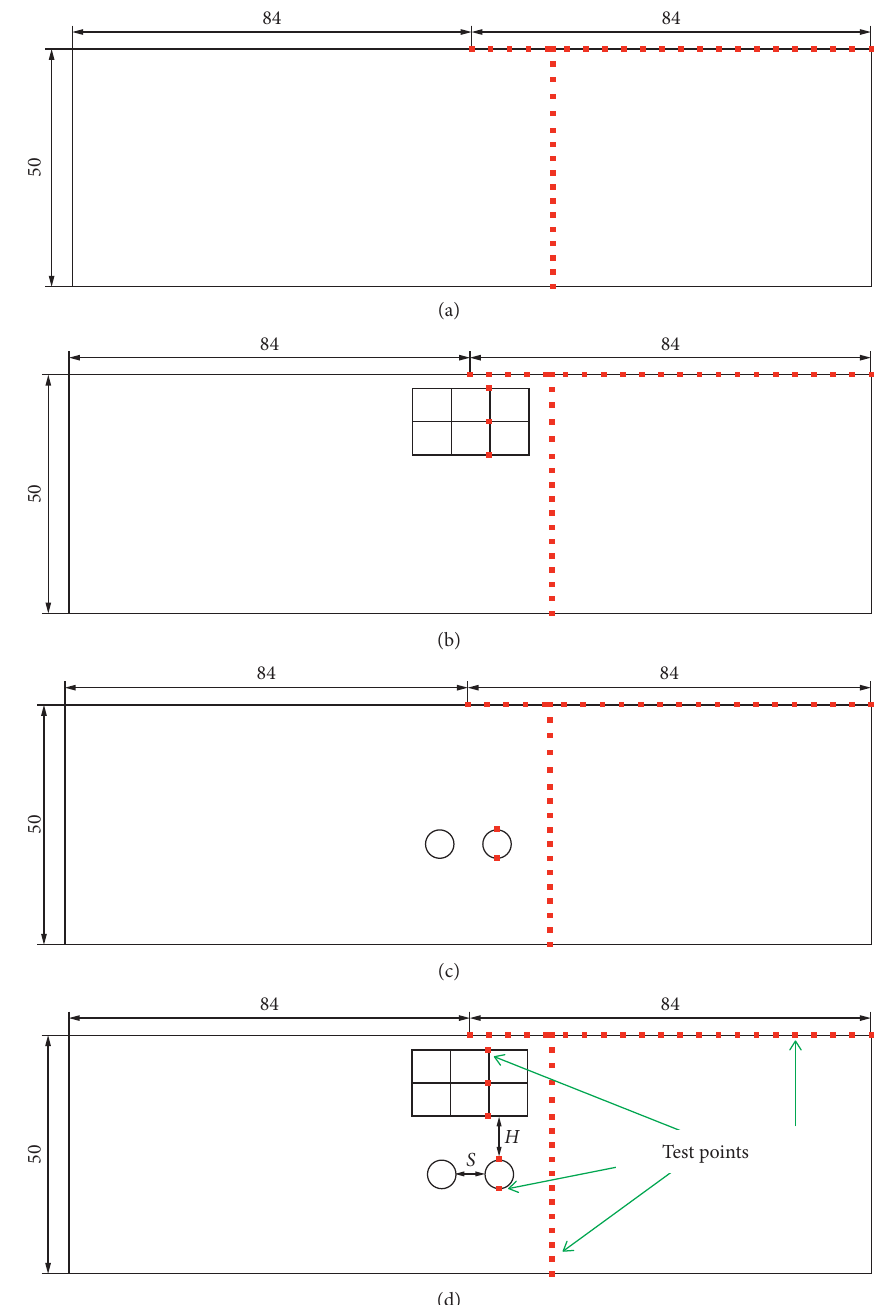
Figure 4: Arrangement of test points (unit: m). (a) Free-field model. (b) Soil-station model. (c) Soil-tunnel model. (d) Soil-tunnel-station